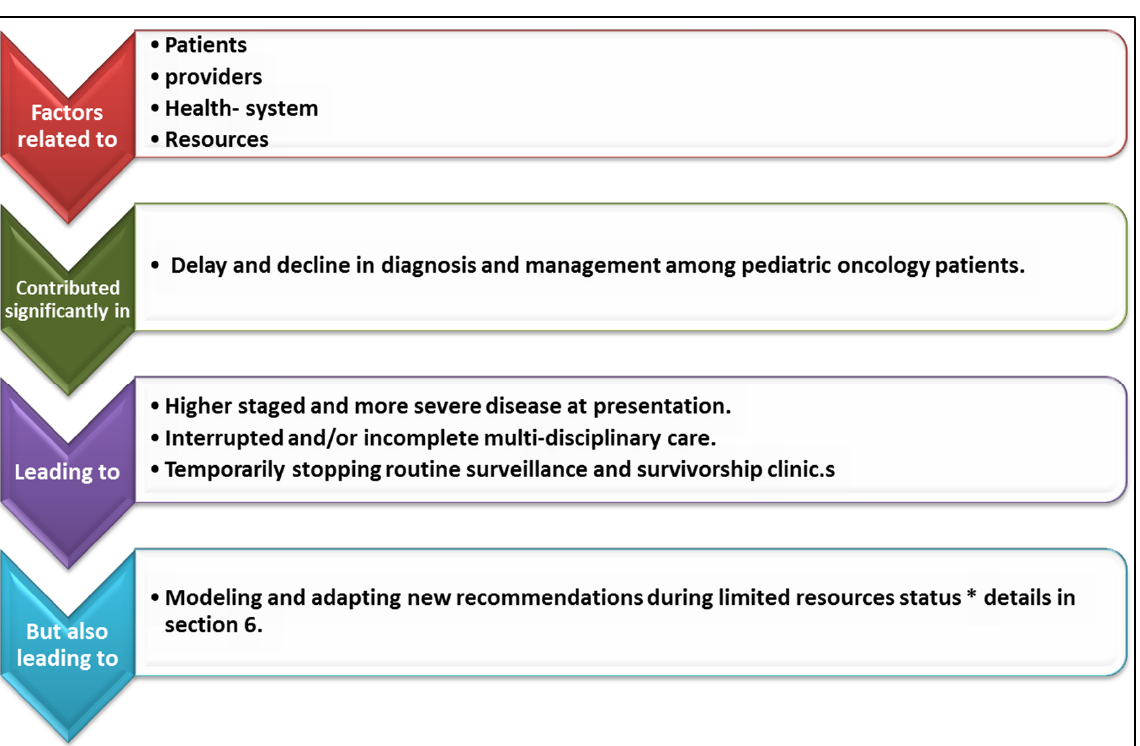
Figure 1. Schematic summarization of the effect of the COVID-19 pandemic on pediatric oncology diagnosis and management. * details in Section 6 entitled Management of the Malignancy during